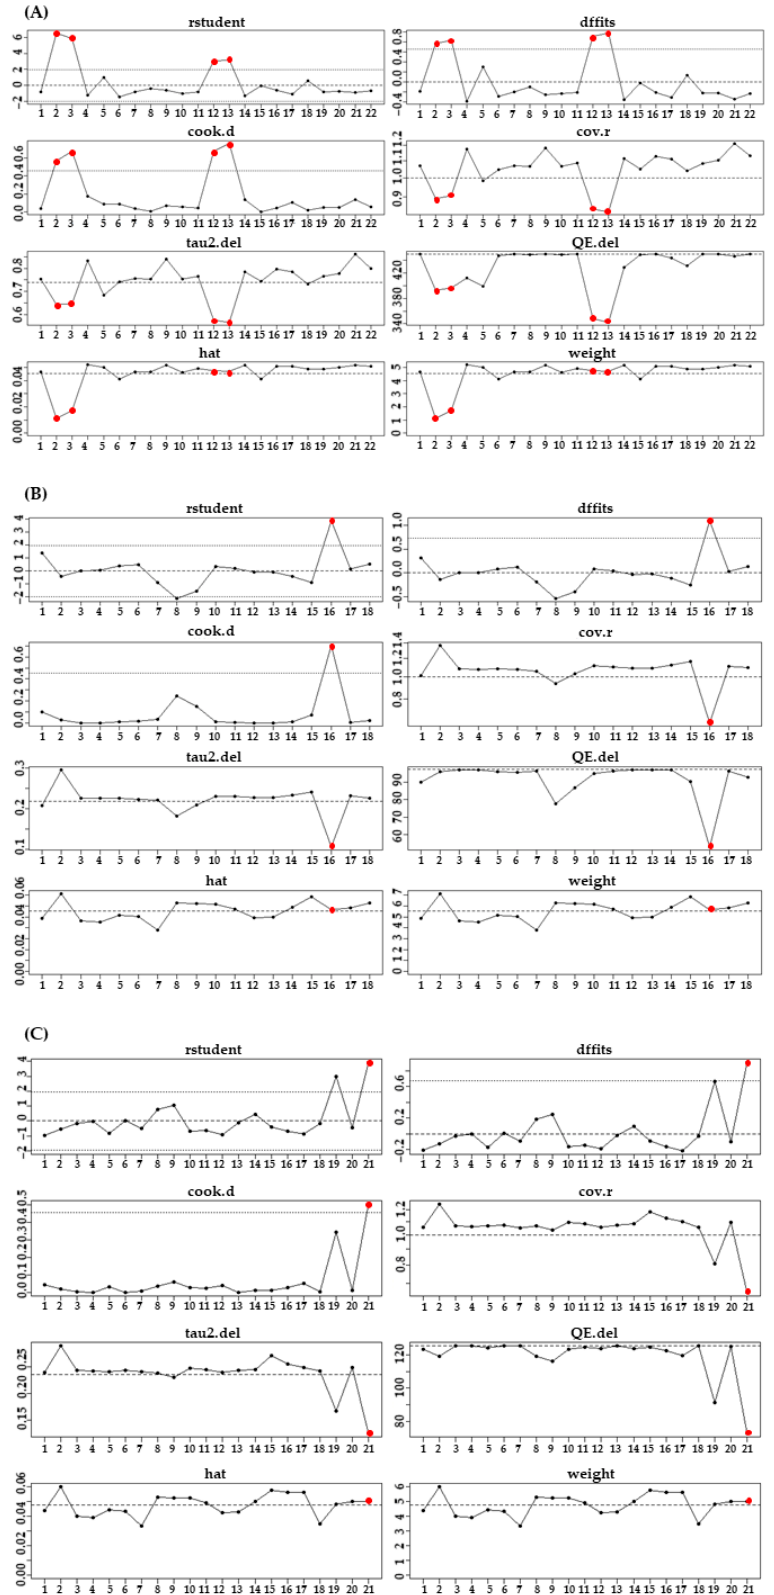
Figure A1. Influence sensitivity analyses result in meta-analyses for the effects of physical exercise on three HRQOL domains in office workers. ( A ) General; ( B ) physical; and ( C ) mental. Comparisons that exerted a very large influence on the overall effect sizes are highlighted in red. HRQOL = health-related quality of life.